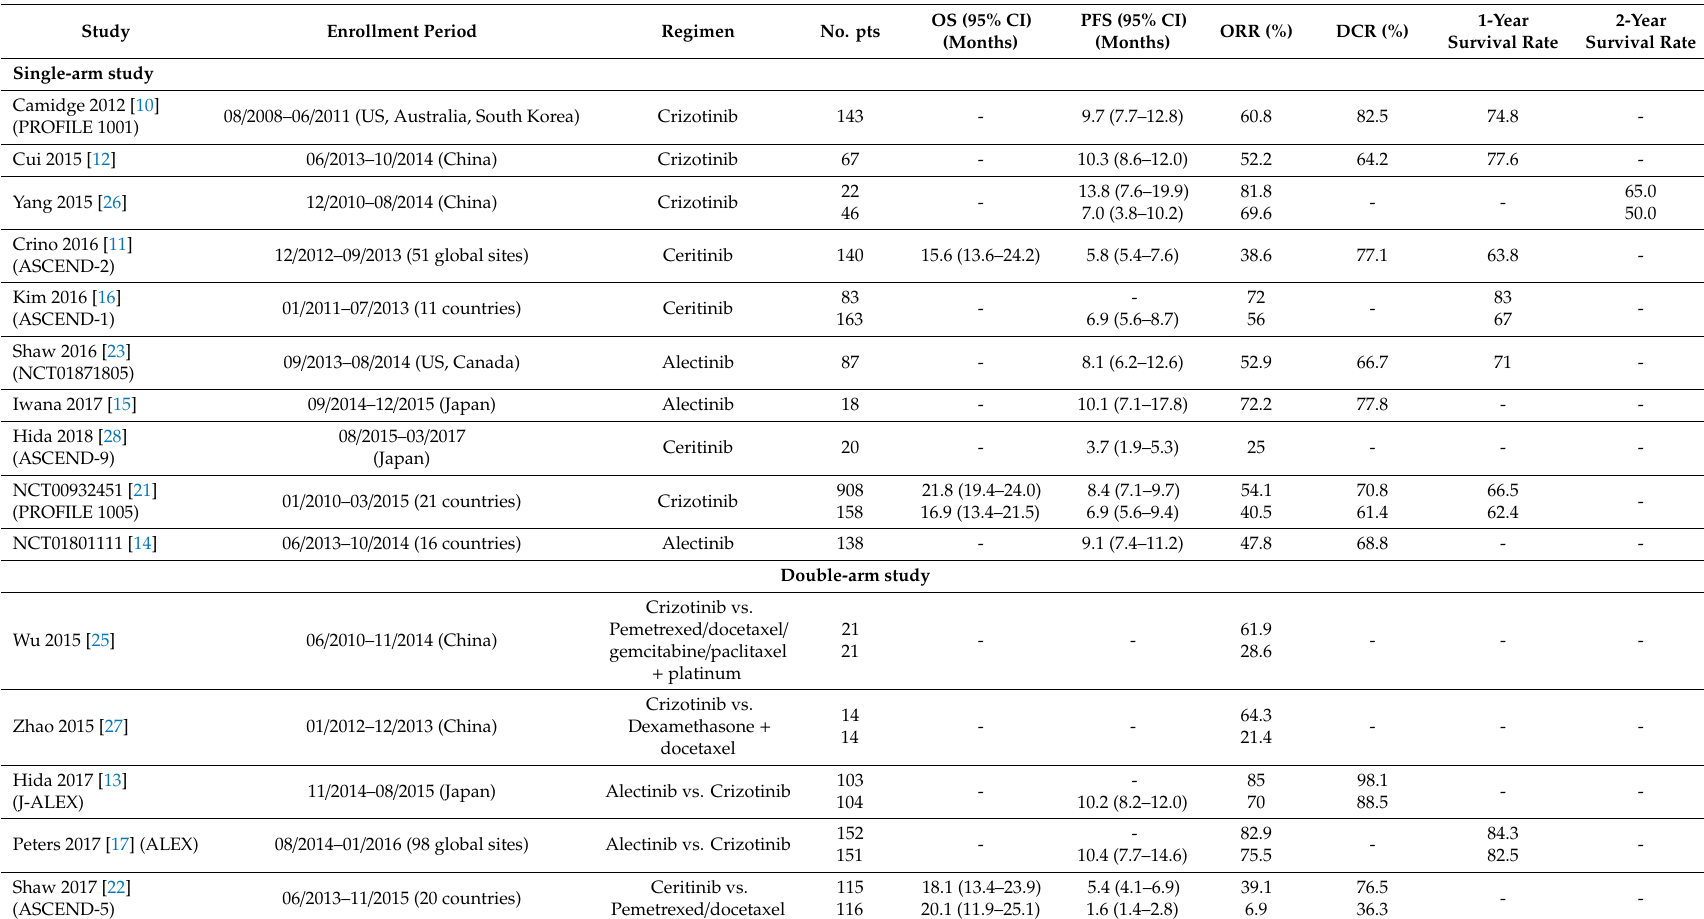
Table 1. General characteristics of clinical trials included in the final